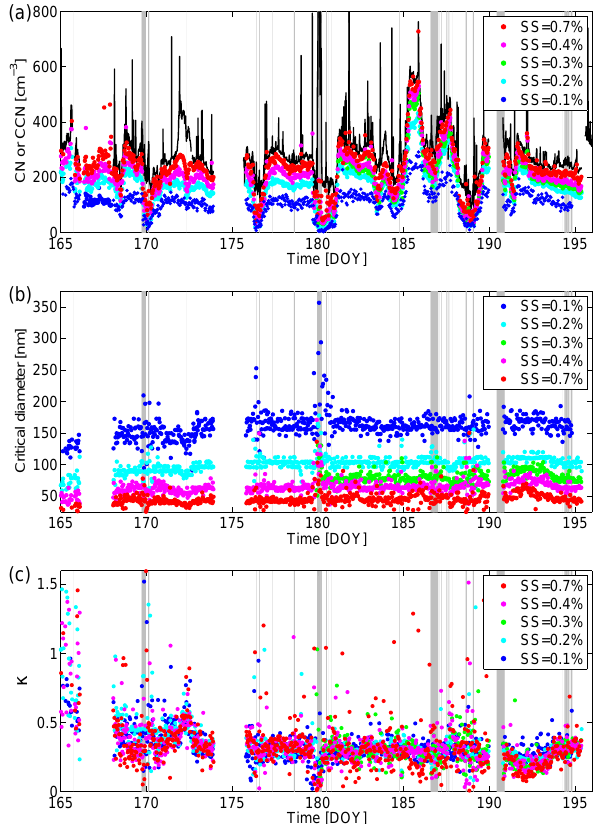
Figure 3. The measured CCN concentrations and associated prop- erties. The grey shaded areas indicate time periods when local land- based contamination cannot be ruled out as determined from the lo- cal wind direction. (a) The measured CCN number concentrations for the different supersaturations. The total particle number con- centration (CN) inferred from the MPSS measurements is indicated with the full black line. (b) The inferred critical diameters. (c) The inferred κ